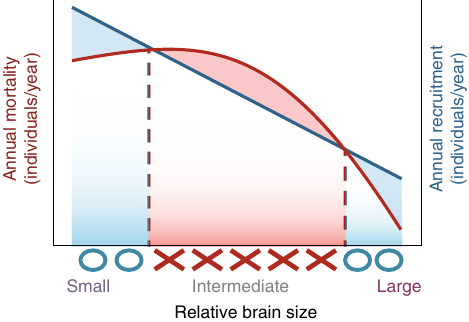
Fig. 5 Potential relationships between relative brain size, annual mortality, and annual recruitment in high-latitude environments. The expected decrease in population recruitment as a function of brain size (blue line) is depicted as a linear function, as indicated by the patterns in Fig. 3b. In contrast, the effect of relative brain size on mortality rates (red line) is depicted as a quadratic function because intermediate brain sizes are likely to be inadequate for dealing with high environmental variability and can reduce the proportion of resources available for the deployment and use of other non-cognitive solutions to environmental variation. The example illustrated here demonstrates a scenario where populations of species